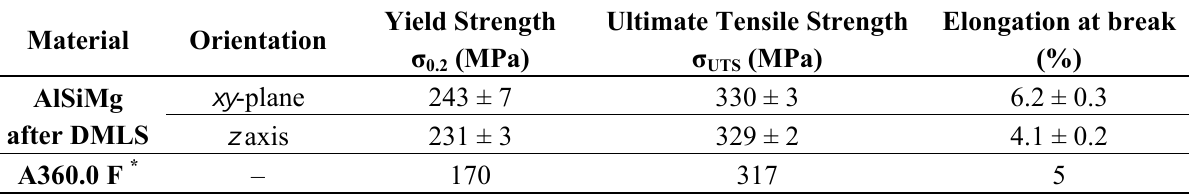
Table 4. Mean values of tensile properties of aluminum alloy DMLS specimens produced according the standard ASTM E8M along different orientations, compared to a similar alloy as-fabricated.